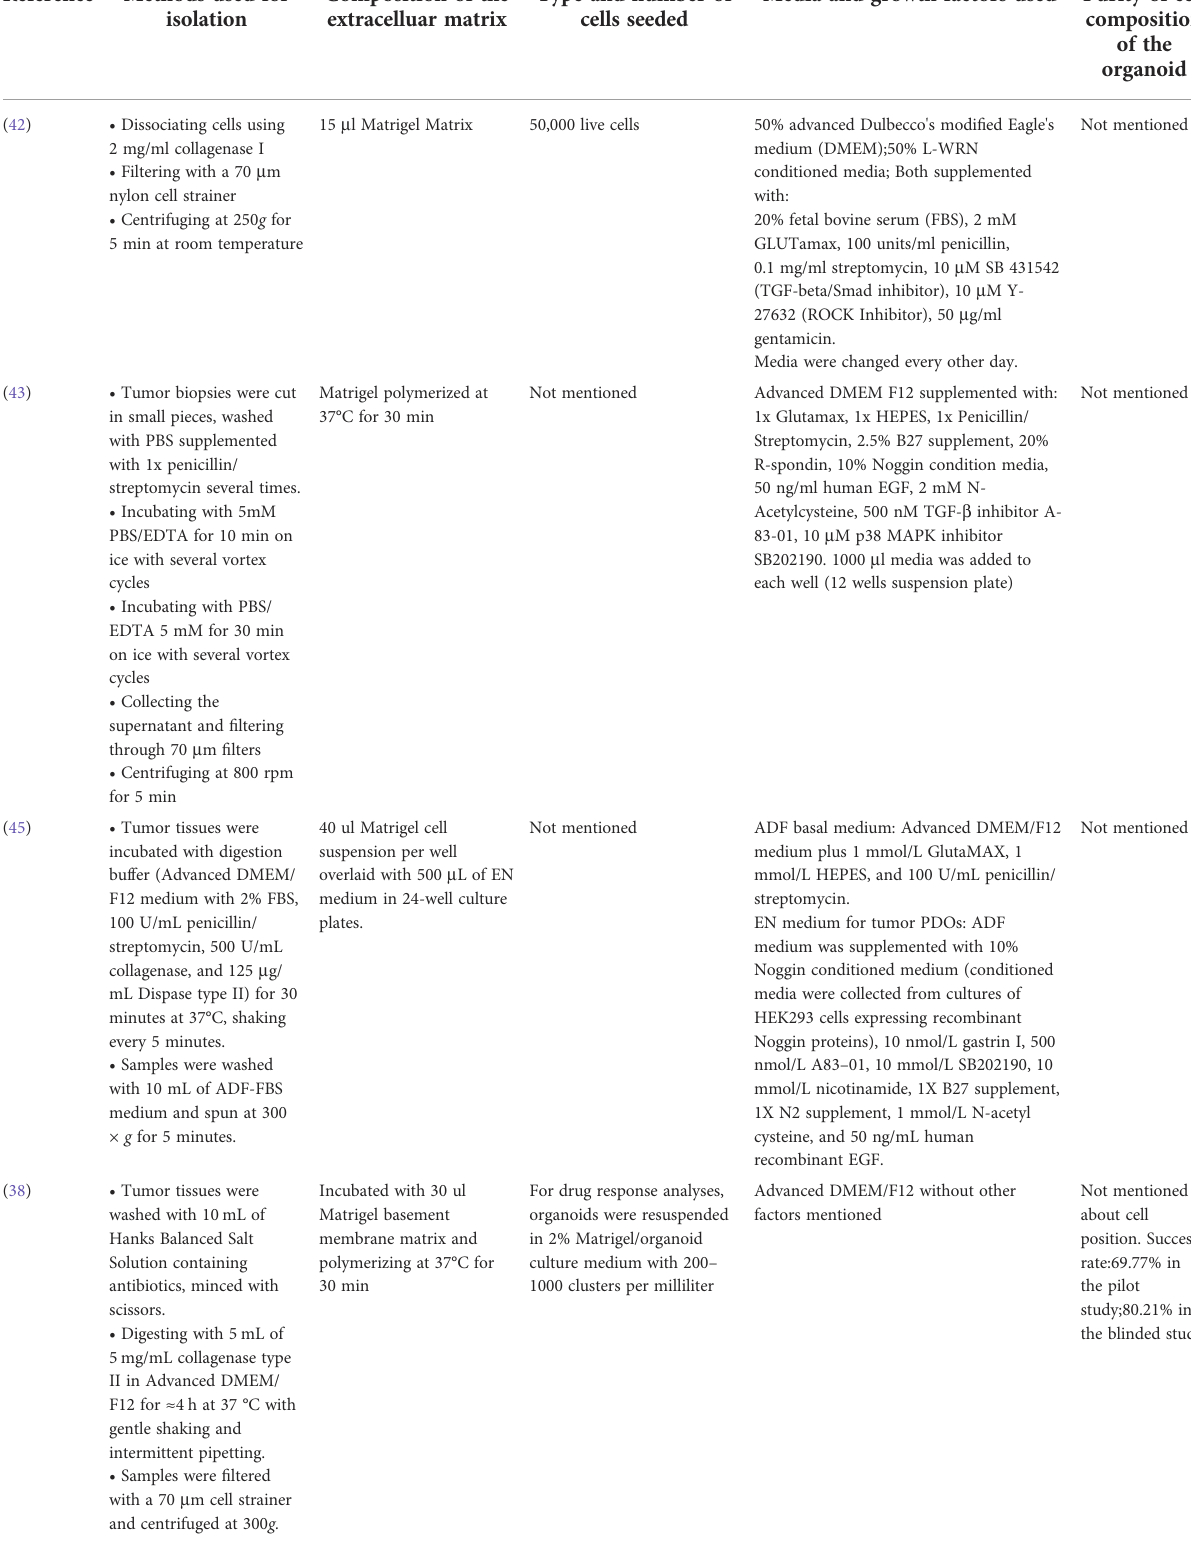
TABLE 3 Methodologic differences and limitations of selected